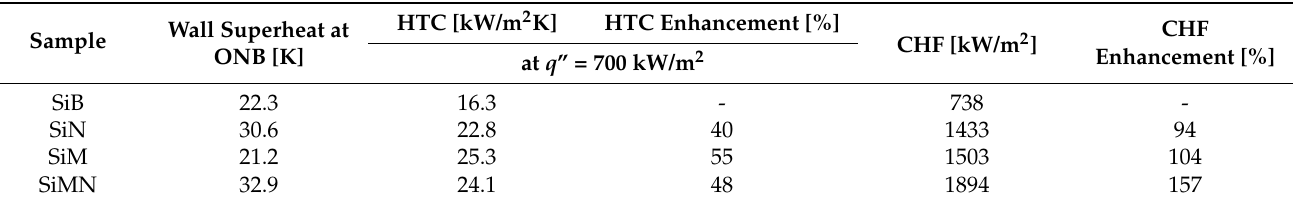
Figure 4. Pool boiling experimental data to confirm micro and nano effects. ( a ) Boiling heat transfer, ( b ) boiling curve. Table 1. Pool boiling results on SiB, SiM, SiN, and SiMN.